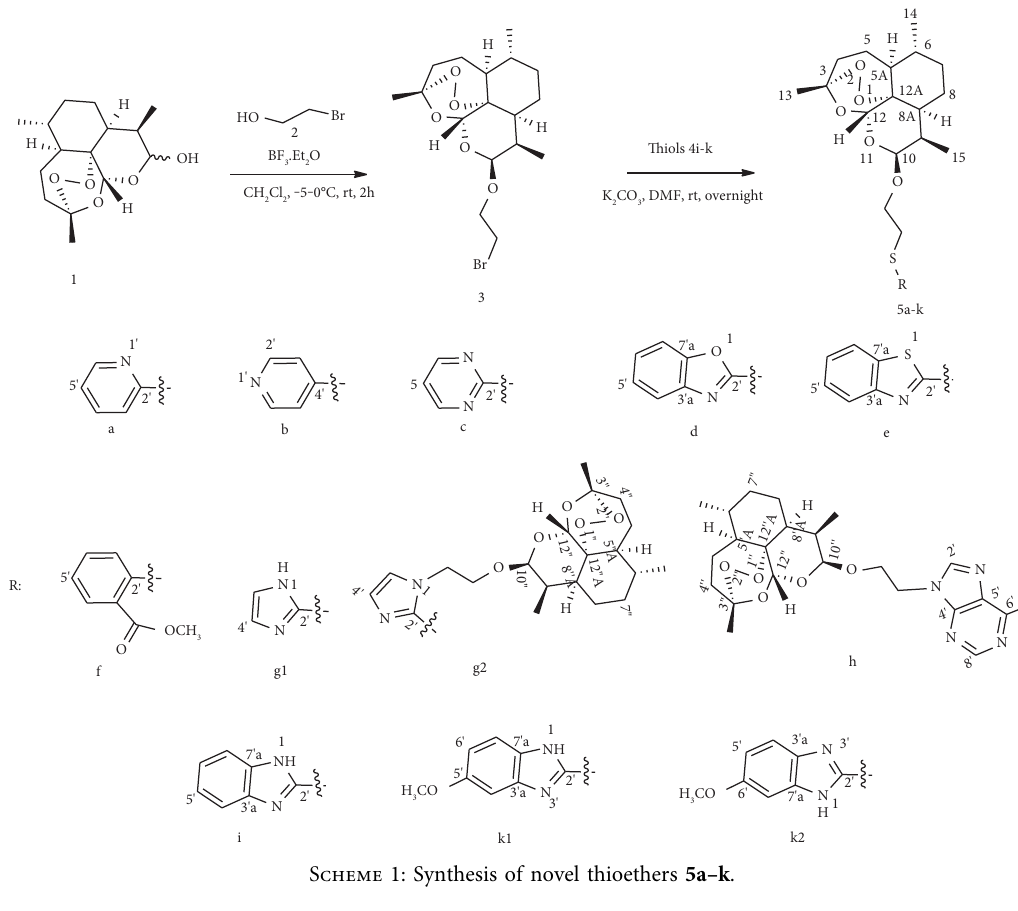
Scheme 1: Synthesis of novel thioethers 5a–k .